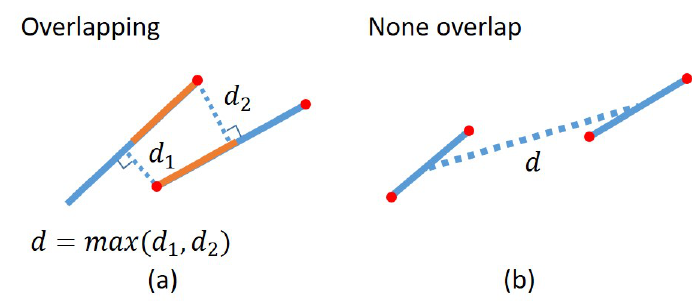
Figure 5. Line distance measurement between two line segments in a 2D image. ( a ) Overlapping case: Calculate the perpendicular distance between each overlapping endpoint and line segment, and take the maximum d = max ( d 1 , d 2 ) as the distance. ( b ) Non-overlapping case: Calculate the distance between the center point of each line